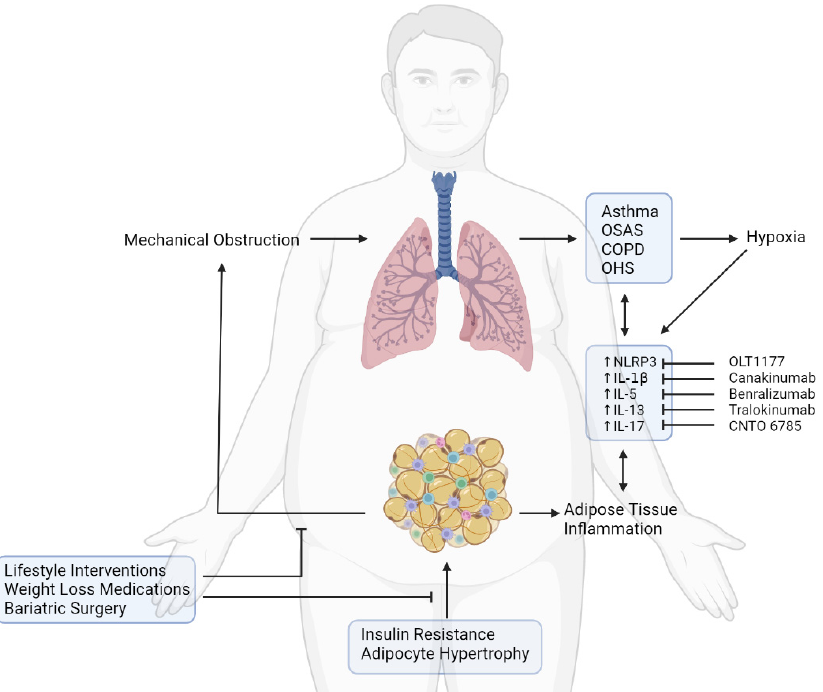
Figure 2. Effects of obesity on pulmonary function and therapeutic strategies for the treatment of lung diseases. Insulin resistance and adipocyte hypertrophy induce adipose tissue inflammation. Excess of adipose tissue is responsible for mechanical obstruction of lung airways, promoting development of asthma, OSAS, COPD, and OHS, which are responsible for hypoxia. Both hypoxia and adipose tissue inflammation foster activation of the NLRP3 inflammasome, increasing levels of pro-inflammatory cytokines (IL-1 β , IL-5, IL-13, IL-17) and promoting development of lung diseases. Improvement in the respiratory function in people with obesity and lung disease could be achieved through therapeutic intervention for weight loss or through pharmacological strategies able to target the inflammasome and its downstream cytokines.